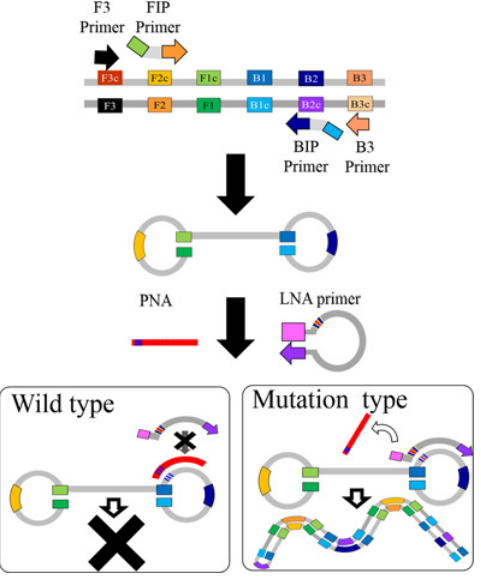
Fig 1. Principle of PNA-LNA mediated LAMP. When the target gene is wild-type, the clamping PNA probe forms a stable duplex with the dumbbell structure, and interferes with the annealing and extension of the LNA primer. On the other hand, when the target gene is mutated, the clamping PNA probe does not anneal with the cDNA because of the single-base mismatch, and the LNA primer breaks its internal interaction to bind the target, and the extension reaction